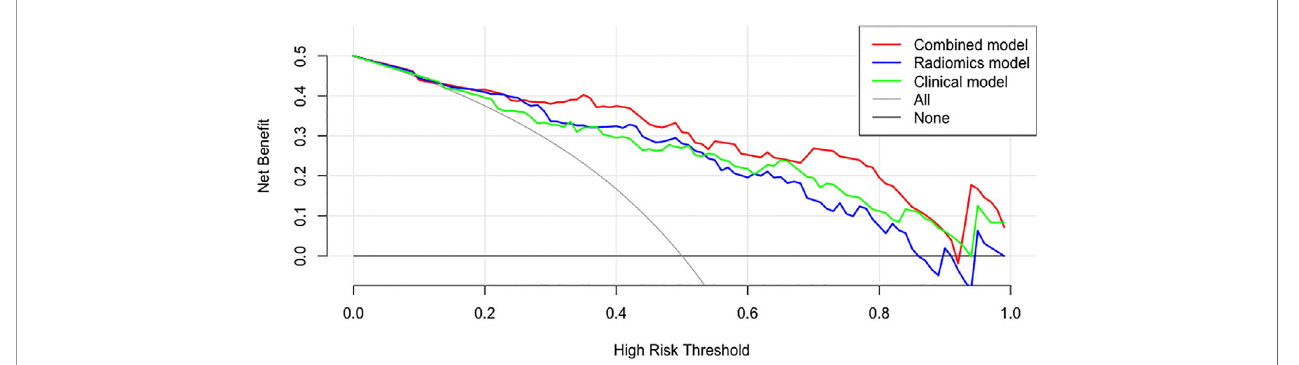
FIGURE 8 | Decision curves of the clinical, radiomics, and clinical-radiomics combined models for predicting